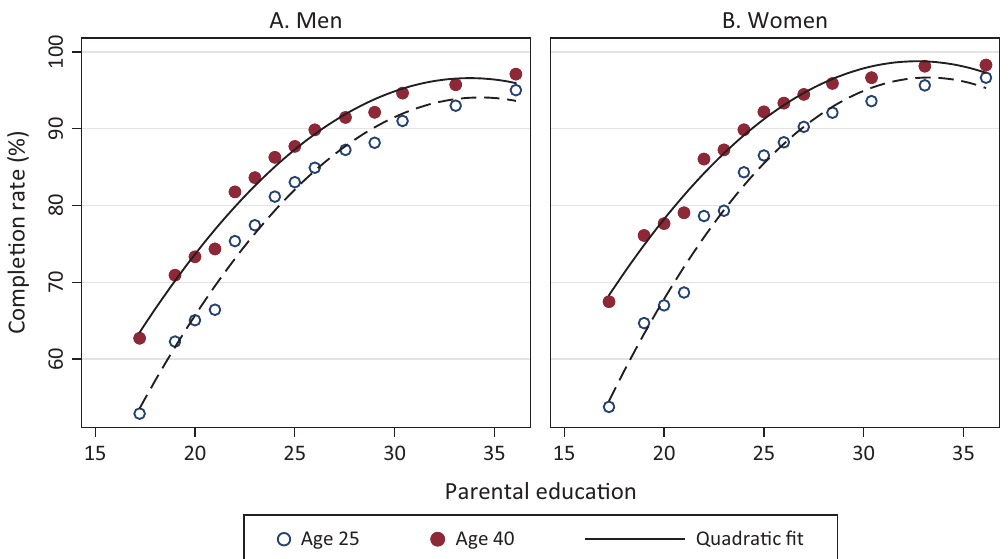
Figure 4. Binned scatter plots of relationship between parental attainment and completion of upper secondary education, by age and gender.